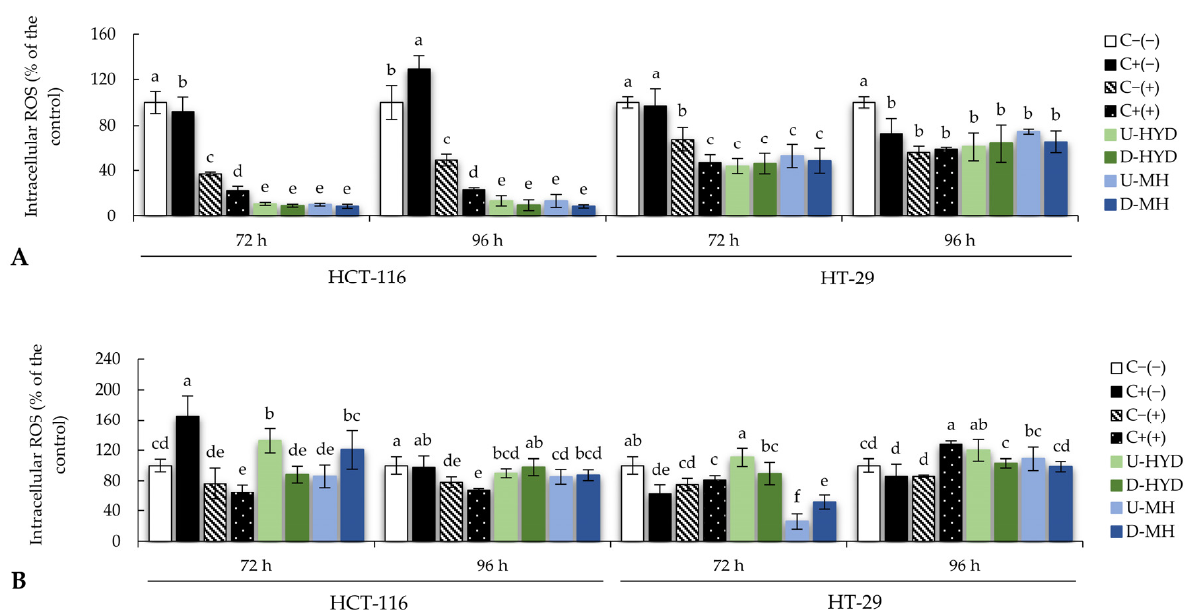
Figure 5. Intracellular ROS production (%) in HCT-116 and HT-29 cells treated with spent media from ( A ) RAW264.7 and ( B ) THP-1 cells exposed HYD and MH before and after digestion at 0.5 mg/mL for 72 and 96 h. Bars represent means, and error bars represent standard deviations (n = 8). Different lowercase letters show significant differences from each other (one-way ANOVA, post hoc Duncan’s test, p ≤ 0.05). Abbreviations: colon cancer cells treated with growth media without LPS (C − ( − )); with growth media with LPS (1 µg/mL) (C+( − )); with non-stimulated macrophage supernatant (C − (+)); with LPS-stimulated macrophage supernatant (C+(+)); undigested WB hydrolysate (U-HYD); digested WB hydrolysate (D-HYD); undigested mousse with WB hydrolysate (U-MH); and undigested mousse with WB hydrolysate (U-MH).